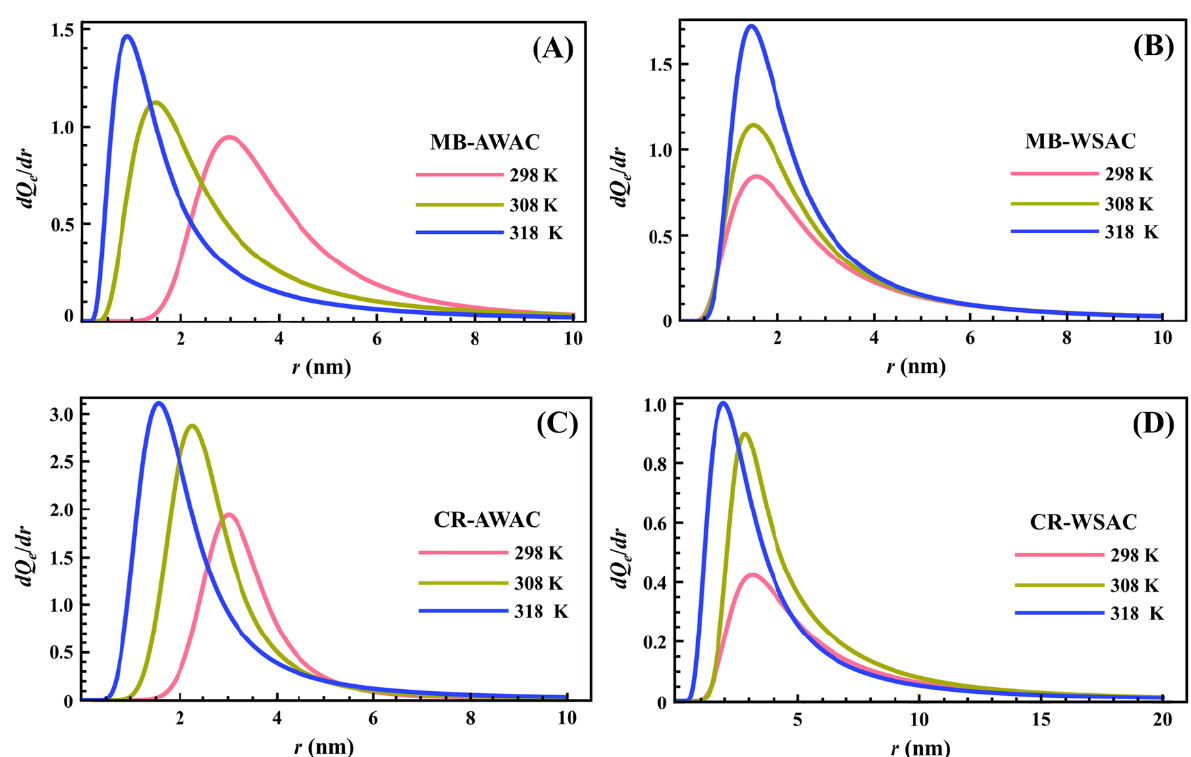
Figure 5. Pore size distribution (PSD) curves of MB-AWAC ( A ), MB-WSAC ( B ), CR-AWAC ( C ), and CR-WSAC ( D ) adsorption systems at different temperatures.